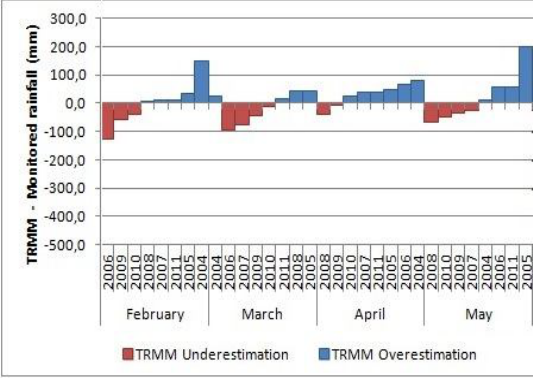
Figure 14. Overestimation and underestimation from February to May